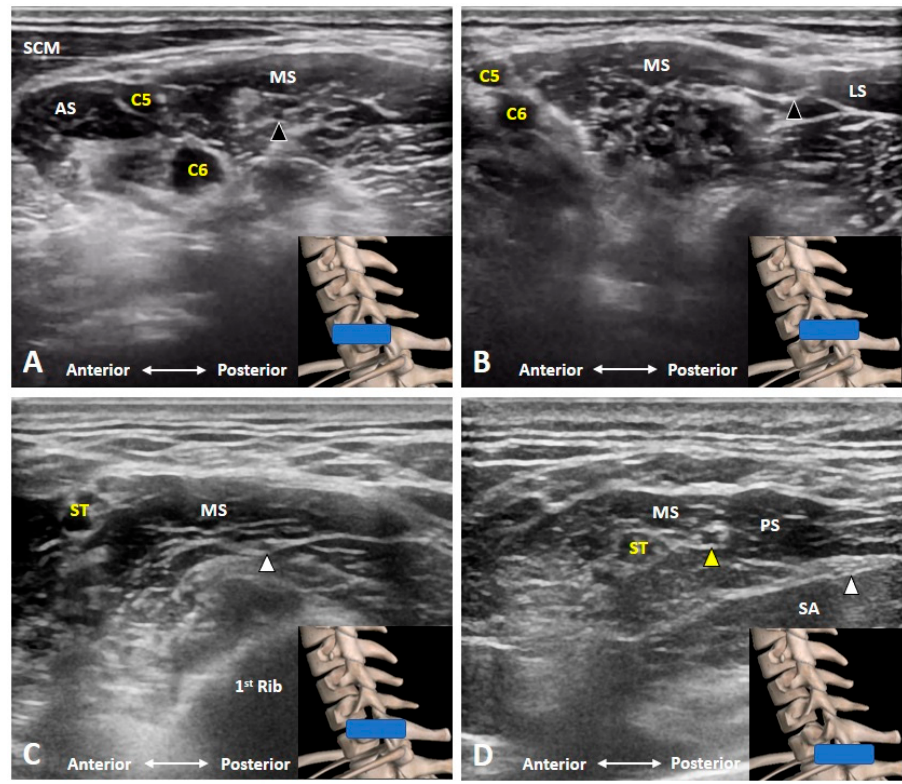
Figure 9. The dorsal scapular nerve (black arrowhead) emerges from the C5 anterior ramus, pierces the medial scalene muscle ( A ) and further courses underneath the levator scapulae muscle ( B ). The long thoracic nerve (white arrowhead) also travels inside the middle scalene muscle ( C ). The suprascapular nerve (yellow arrowhead) branches from the superior trunk of the brachial plexus ( D ). AS: anterior scalene muscle; LS: levator scapulae muscle; MS: middle scalene muscle; PS: posterior scalene muscle; SCM: sternocleidomastoid muscle; ST: superior trunk; SA: serratus anterior muscle. The blue rectangles at the bottom-right corners represent the transducer position.